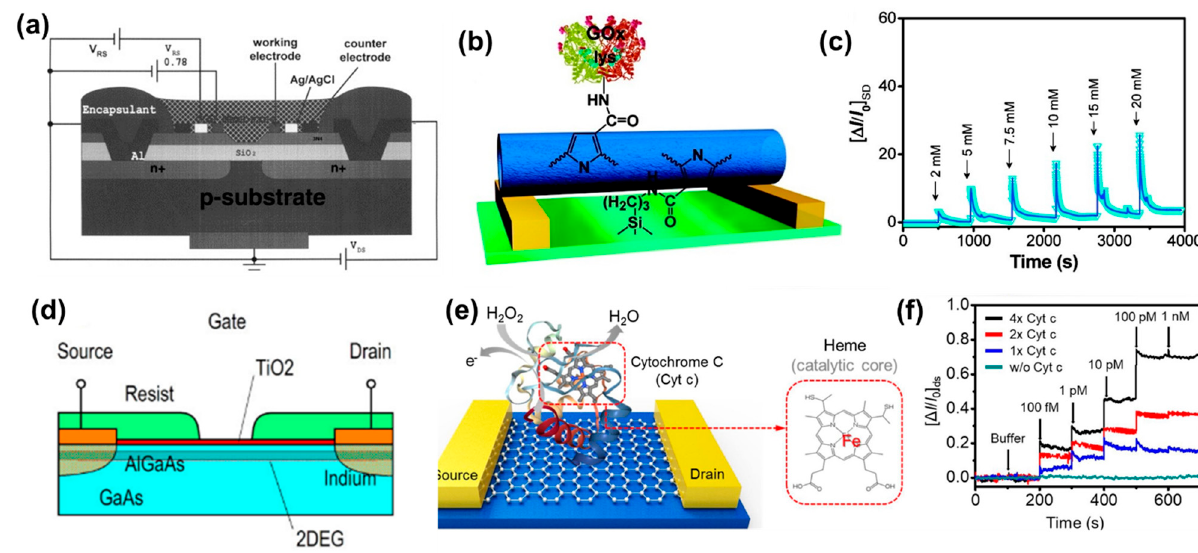
Figure 7. ( a ) A solid ISFET glucose sensor with a ladder-type platinum electrode as the working electrode, a counter electrode and an Ag/AgCl reference electrode. Reprinted from [75] with permission from Elsevier. ( b ) GOD-Carboxylated Polypyrrole nanotubes FET sensor for detection of H 2 O 2 and glucose. Reprinted (adapted) with permission from [57]. Copyright 2008 American Chemical Society. ( c ) Real time current response due to of the sensor described in Figure 7b when it is exposed to H 2 O 2 ranging from 2–20 mM. Reprinted (adapted) with permission from [57]. Copyright 2008 American Chemical Society. ( d ) A TiO 2 thin film FET to monitor the cell viability with H 2 O 2 as the marker. Reprinted with permission from [64]. ( e ) Schematics of a cytochrome-c (cyt c) based ultrasensitive H 2 O 2 sensor. Reprinted from [73] with permission from Elsevier. ( f ) Plot showing the stepped current response, when the sensor is exposed to various concentration of H 2 O 2 (0.1pM to 1nM), while different color solid line represents the cytochrome-c loading on the sensor no cyt c(green), 1× cyt c(blue), 2× cyt c(red) and 4× cyt c (black). Reprinted from [73] with permission from Elsevier.